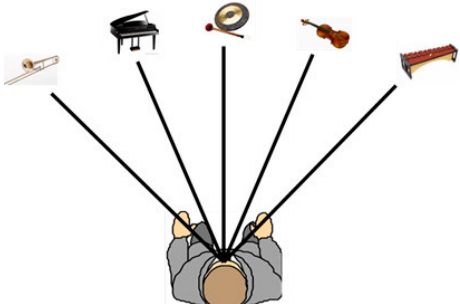
Figure 8. Stereo sound feedback of the assisting system. Sounds of five directions of traversable area with or without water hazard detection are presented by five musical instruments in the virtual 3D space, including trumpet, piano, gong, violin and xylophone.